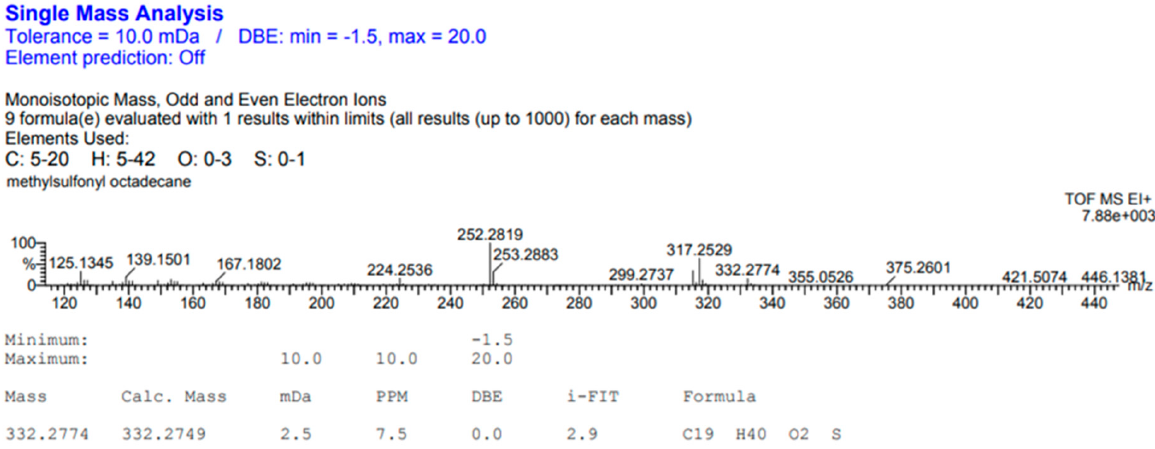
Figure A7. Mass spectrum for methylsulfonyloctadecane.